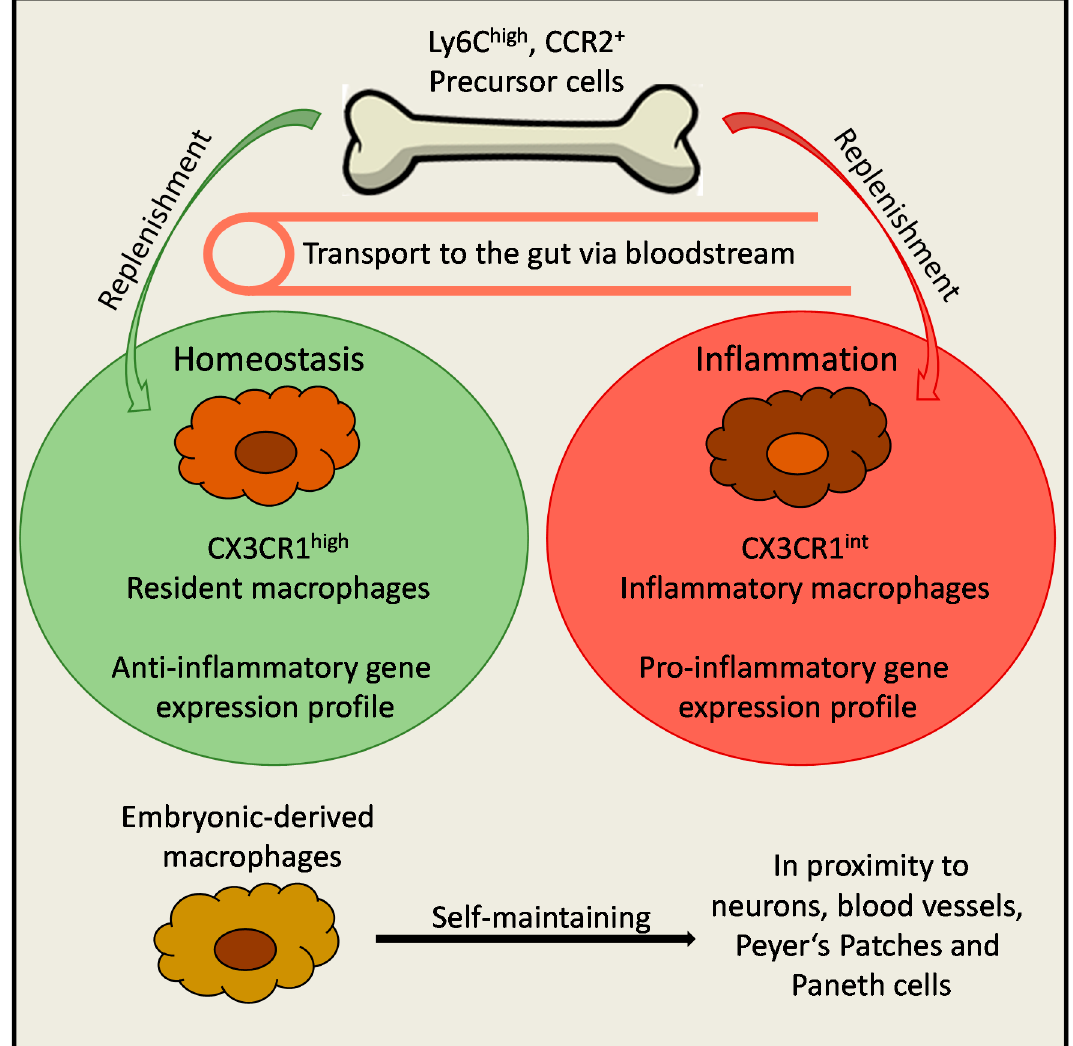
Figure 1. Development of macrophages in the gut. Precursor cells in the bone marrow express high levels of Ly6C and Ccr2 , which are needed for their egress to the blood stream. Under homeostatic conditions, CX3CR1 high resident, anti-inflammatory macrophages develop from these precursor cells. However, under inflammatory conditions, this process is interrupted, leading to the accumulation of CX3CR1 int inflammatory macrophages. In addition to constantly replenished macrophages, also self-maintaining embryonic-derived macrophages are present in the gut. They are located in close proximity to neurons, blood vessels, Peyer’s patches and Paneth cells.